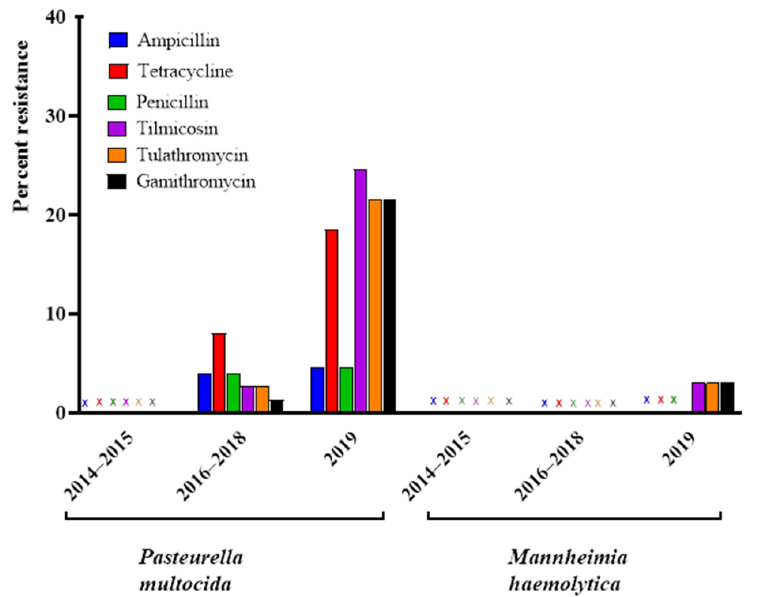
Figure 1. Percentage of Pasteurella multocida ( n = 140) and Mannheimia haemolytica ( n = 88) isolates classified as resistant to selected antimicrobials determined by antimicrobial susceptibility testing over the 2014–2019 collection period, (X) signifies no resistance observed.